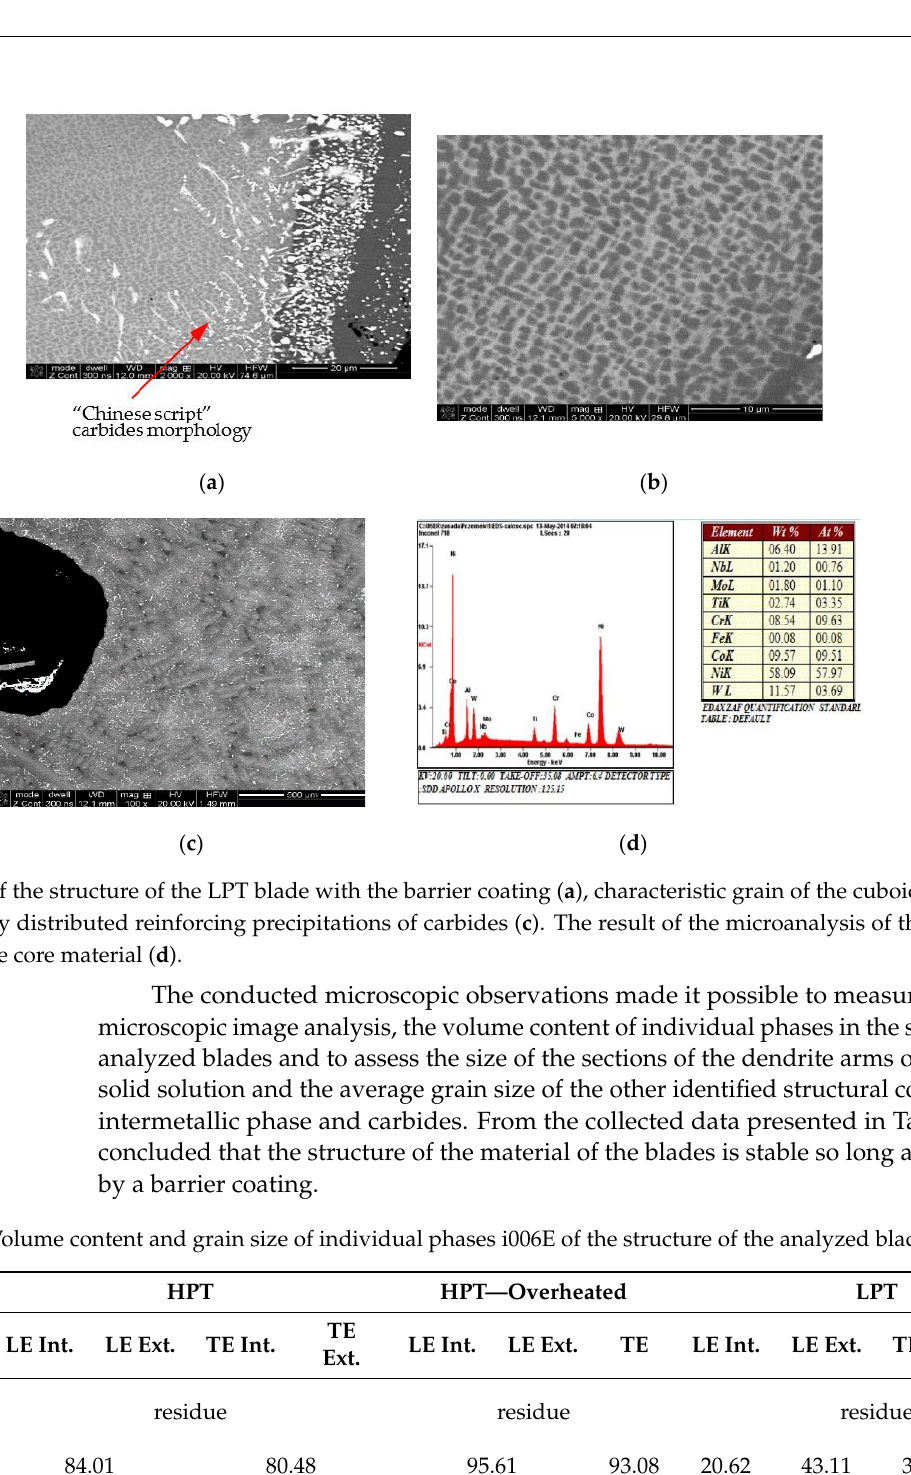
Table 4. Volume content and grain size of individual phases i006E of the structure of the analyzed blades.